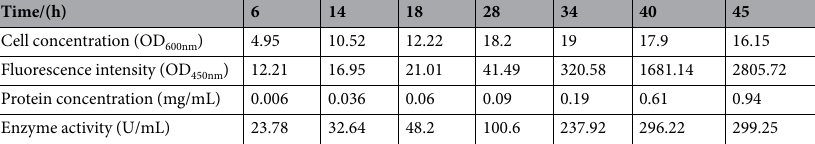
(Fig. 6b; Table 2). In accordance with the enhanced GFP fluorescence intensity, the extracellular expression level of sfGFP-ARG1 as well as its arginase activity increased up to 0.19 mg/mL and 237.92 U/mL, respectively (Fig. 6c,d). The original concentration of fusion protein sfGFP-ARG1 was 0.006 mg/mL in the culture medium after fermentation for 6 hours, and finally with the concentration of 0.19 mg/mL after 34 hours’ fermentation, which exhibited an increased expression level of 31 folds approximately (Fig. 6c; Table 2; Suppl. Figure 3). Along with the dramatically increased protein levels, the enzyme activity of the fusion protein sfGFP-ARG1 in the cul- ture media enhanced 10 fold from 23.78 U/mg to 237.92 U/mg during the fermentation process (Fig. 6d; Table 2). It has to be emphasized that the cell density only increased around 4-fold in the fermentation process, with the OD 600nm values at the initial and final stages of fermentation being 4.95 and 19, respectively (Fig. 6a; Table 2). The relative constant cell density indicated that the increased sfGFP-ARG1 levels in the cell culture media was mainly caused by the enhanced extracellular secretion of sfGFP-ARG1.